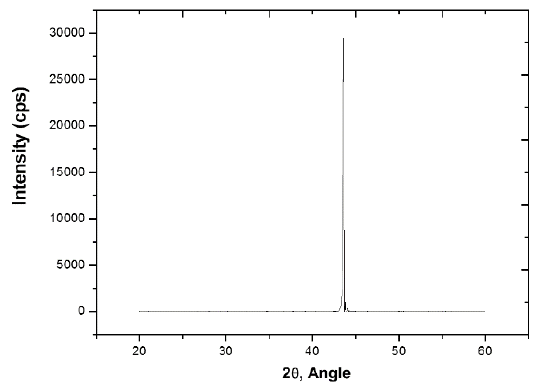
Figure 2. XRD pattern. Uncoated diamond crystals (hot